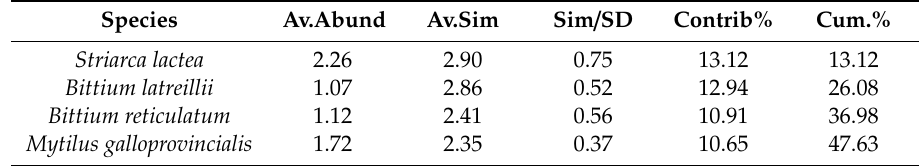
Table 4. Results of the similarity percentages–species contribution analysis (SIMPER), showing molluscan species mostly responsible for the 22.04% similarity among habitats. (Cum%-50% cut-o ff ).